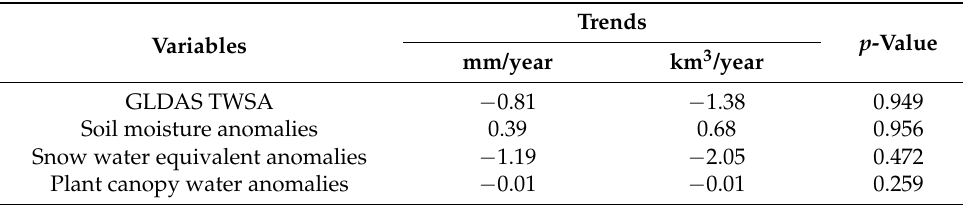
Table 4. Trends in TWSA, soil moisture, snow water equivalent, and plant canopy water of the Aral Sea Basin from GLDAS.